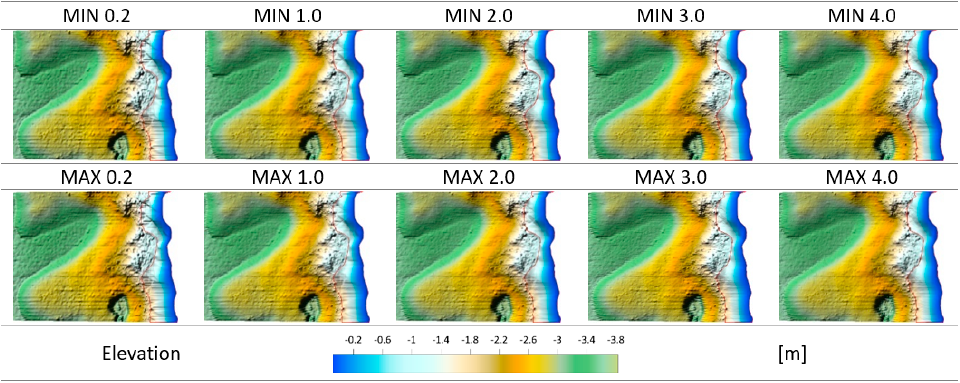
Figure 14. Comparison of DBMs for IDW.